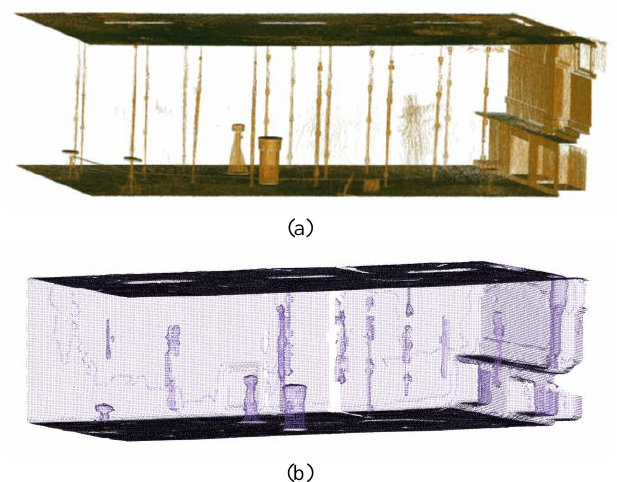
Figure 17. Point cloud of the photogrammetric test